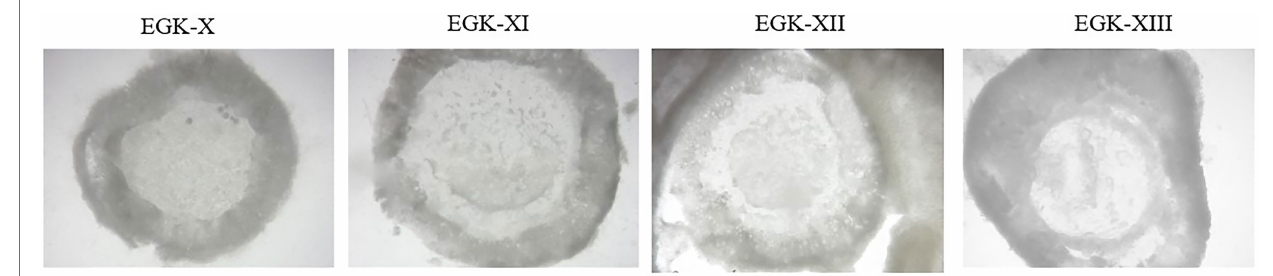
FIGURE 2 | Ventral view of the blastoderm from stages EGX to EGXIII— ©